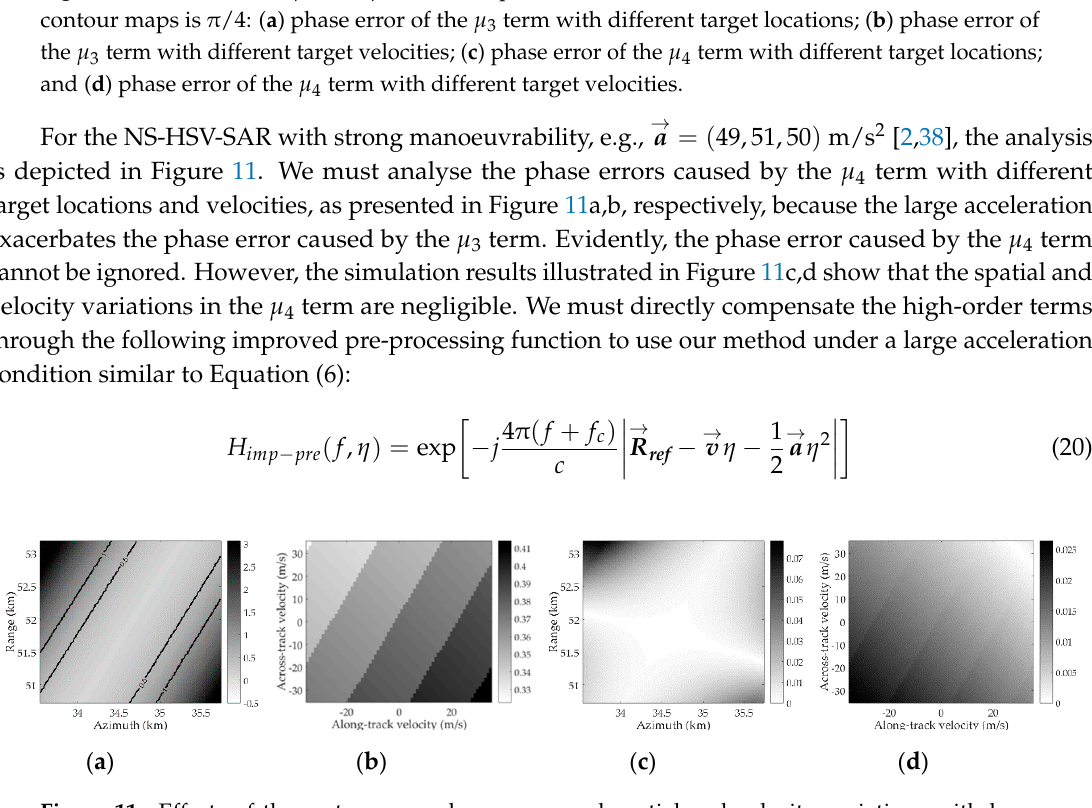
Y N Figure 12. Flowchart of the proposed GMTIm method for handling multiple targets.